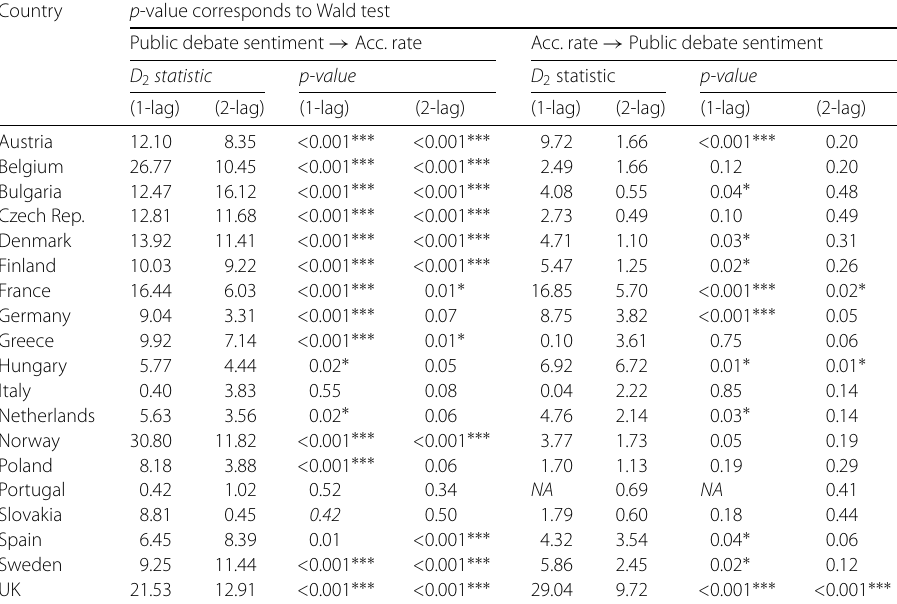
Table 3 Granger-causality test results. Granger-causality test of interactions between asylum acceptance rates and public debate sentiment in the media. The 10 asylum seekers’ countries of origin with the most decisions made (both accepted and rejected) are included in the regressions. We report Granger-causal testing for 1-month (1-lag) and 2-month (2-lag) lagged VAR models. Locations with NA result from monthly data not being available from the EU database. The D 2 statistic is computed as in [71] and is the result of combining Granger tests from multiply imputed datasets Country p -value corresponds to Wald test Public debate sentiment → Acc.